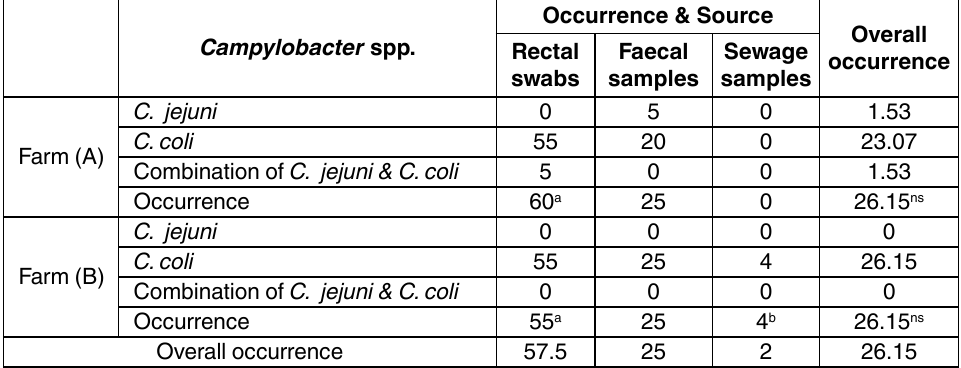
table 3. Details of Campylobacter spp. isolates from different sources Campylobacter spp.